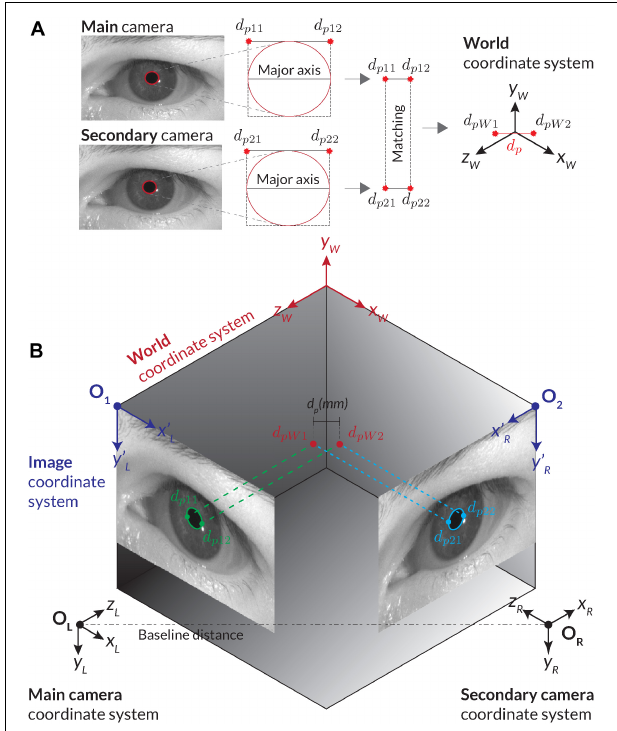
FIGURE 6 | Illustration of calculating the absolute pupil diameter with the stereo vision set-up. (A) For the corresponding stereo images, two pupil detections are carried out. We use the ellipses of the pupil detections and their minimal encompassing rectangle as feature points for matching. Through triangulation, the corresponding stereo images are transformed into world coordinates. The absolute pupil diameter is calculated with the Euclidian distance between the two world coordinates. (B) Procedure of the stereo transformation with the main and second cameras’